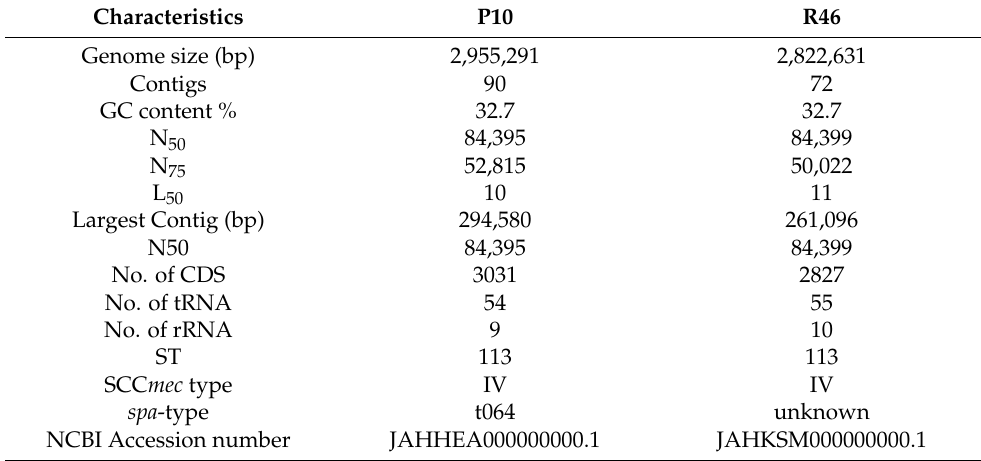
Table 2. Genomic features and characteristics of MRSA strains P10 and